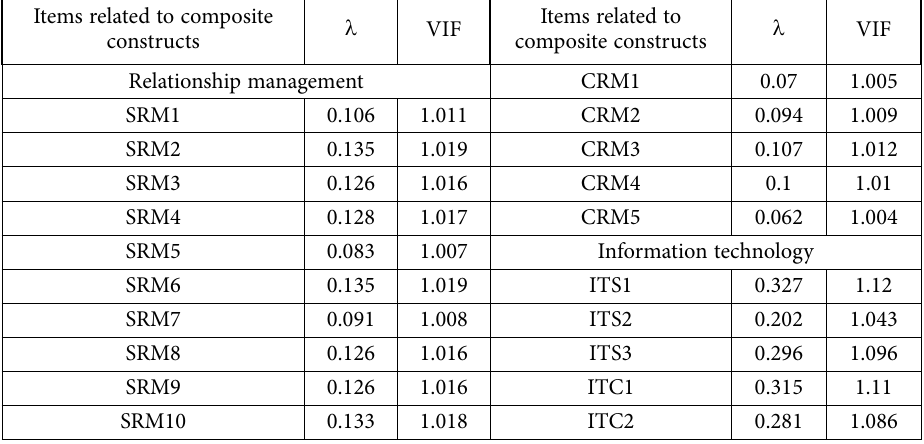
Table 4. Results of composite constructs’ validity assessment